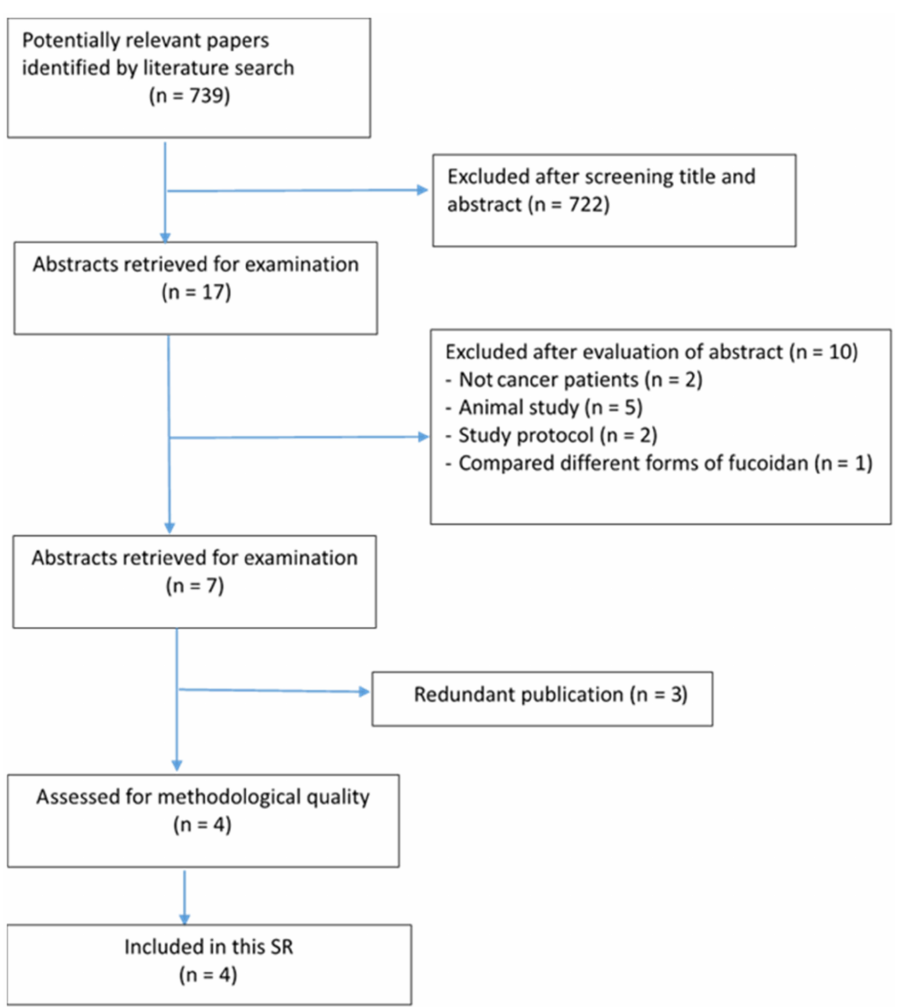
Figure 1. Flow chart for identification and selection of